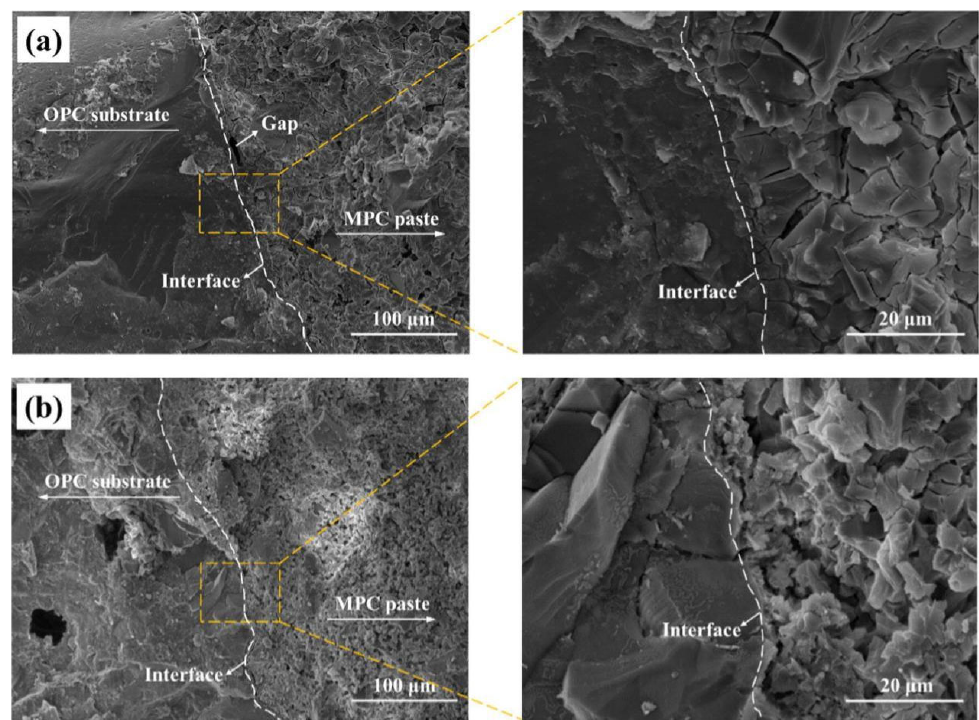
Figure 11. SEM micrograph of the microstructure of the interface (Magnification 500 × and 3000 × ) between old OPC substrate and different MPC matrices with different molar ratios of magnesia and phosphate (7-day-old samples): ( a ) M/P = 10; ( b ) M/P = 14 [59]. (Adapted and reprinted with permission from ref. [59], © 2018, Construction and Building Materials ).